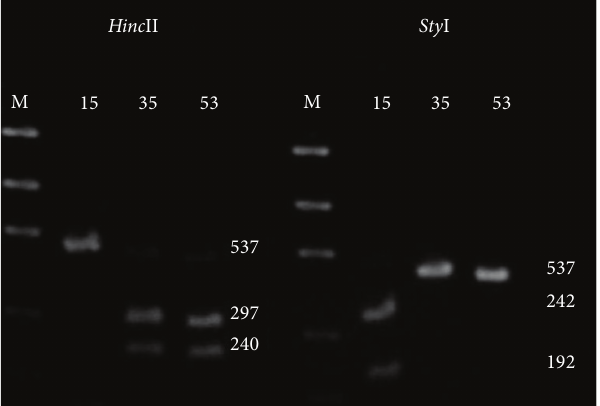
Figure 3: PCR-RFLP fingerprint of T. brasiliensis from three localities produced with Sty I and Hinc II enzymes on 2.0% agarose gel. M: DNA ladder 100bp (New England Biolabs), 15: Salgueiro , 35: M˜ae d’´agua , and 53: S˜ao Jos´e